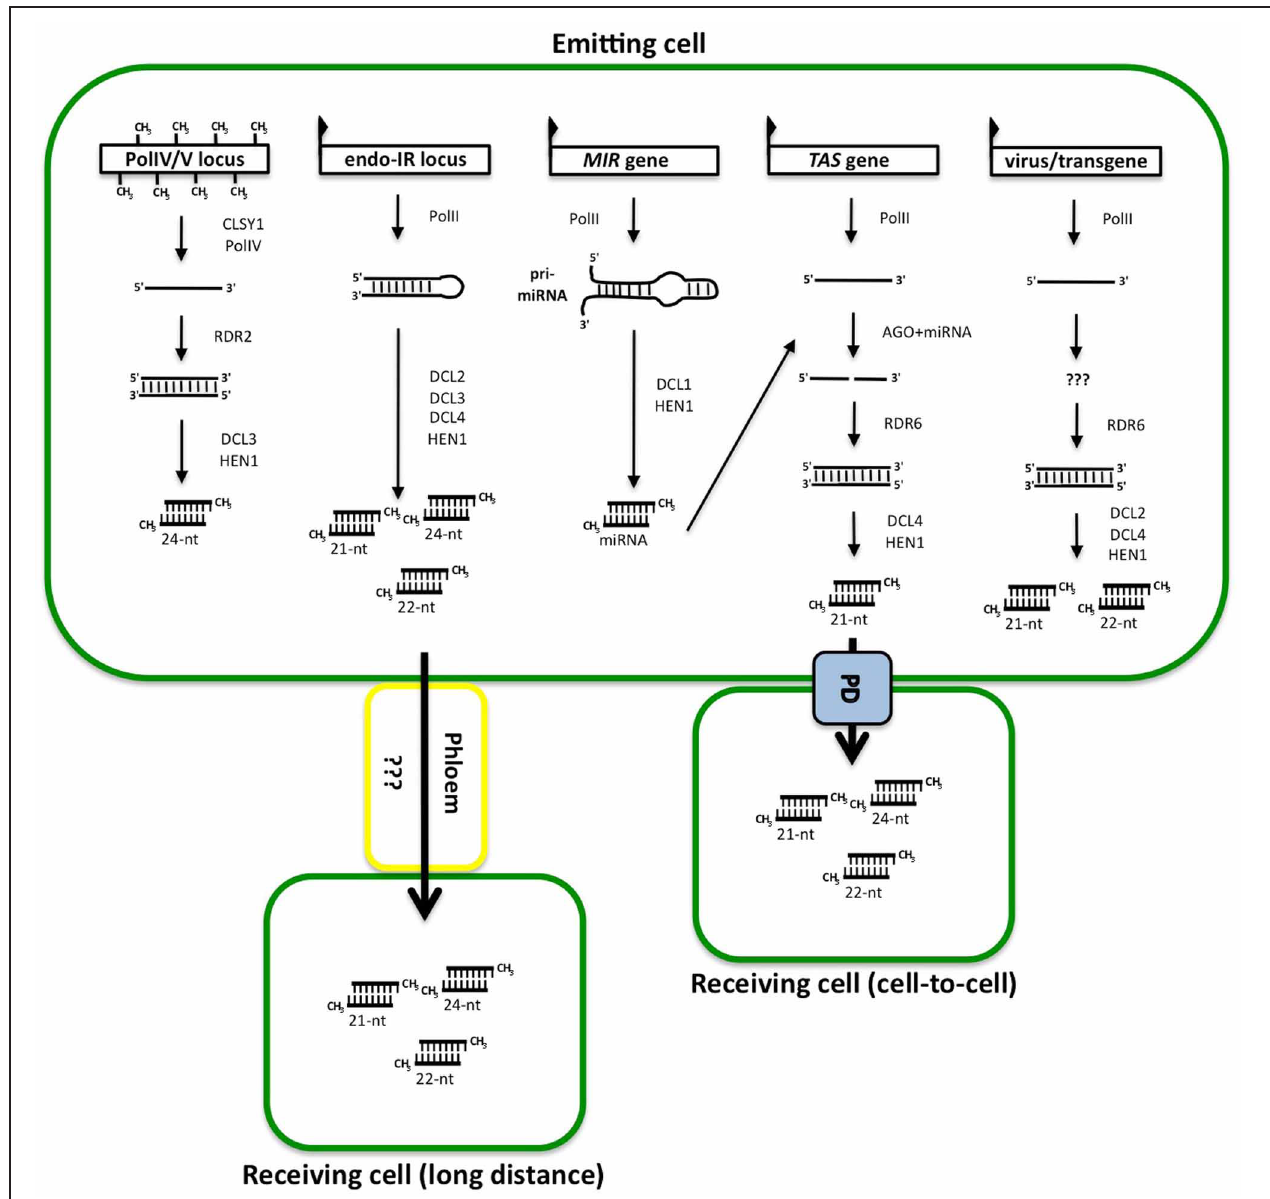
FIGURE 1 | Cascades of reactions leading to the production of sRNA duplexes, hypothetical constituent of the gene silencing signal. The first RNA molecule is produced by RNA polymerases either from a silent locus (PolIV/V locus), an endogenous inverted-repeat (endo-IR locus), a miRNA ( MIR ) gene, a TAS gene or an integrated virus or transgene. The molecules are either folding back on themselves or made into dsRNA by RDR proteins